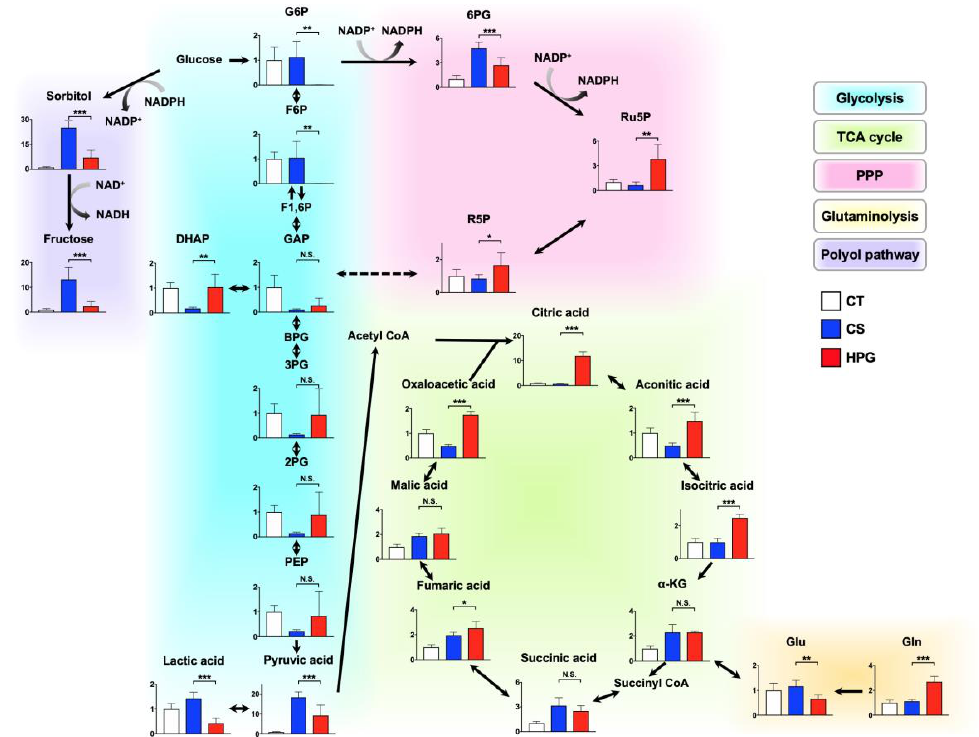
Figure 4. Metabolome data map after 24-h heart preservation in glycolysis, tricarboxylic acid (TCA) cycle, pentose phosphate pathway (PPP), glutaminolysis, and polyol pathway. Bar graphs indicate fold changes relative to the control (CT) group. The lack of a bar graph representation for a given metabolite means that the metabolite was not detected. Data in each bar are presented as mean ± standard error of the mean. N.S., not significant. * p < 0.05, ** p < 0.01, *** p < 0.001. CS, cold storage; HPG, high-pressure gas; G6P, glucose 6-phosphate; F6P, fructose-6-phosphate; F1,6P, fructose 1,6-bisphosphate; GAP, glyceraldehyde 3-phosphate; DHAP, dihydroxyacetone phosphate; BPG, bisphosphoglycerate; 3-PG, 3-phosphoglycerate; 2-PG, 2-phosphoglycerate; PEP, phosphoenolpyruvate; α -KG, α -ketoglutarate; 6PG, 6-phosphogluconate; Ru5P, ribulose-5-phosphate; R5P, ribose-5-phosphate; Glu, glutamic acid; Gln,